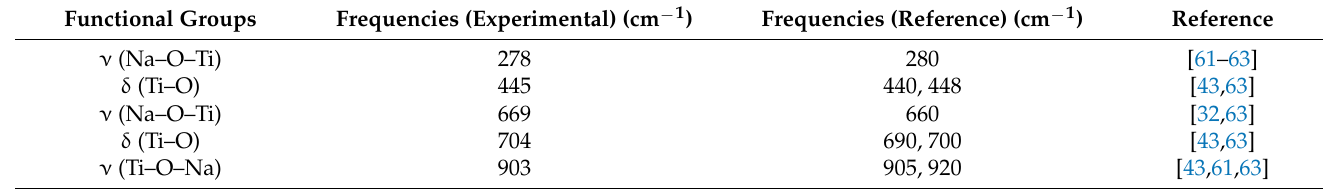
Figure 3. X-ray diffraction spectra of T, T5 samples without alkali-sodium treatment and T-S, T5-S samples with alkali-sodium treatment ( a ), where marked peaks are assigned to sodium titanate; Raman spectra of T, T5 samples without alkali-sodium treatment and T-S, T5-S samples with alkali-sodium treatment ( b ). Table 1. Raman frequencies and assignments of functional groups in sodium titanate samples. Functional